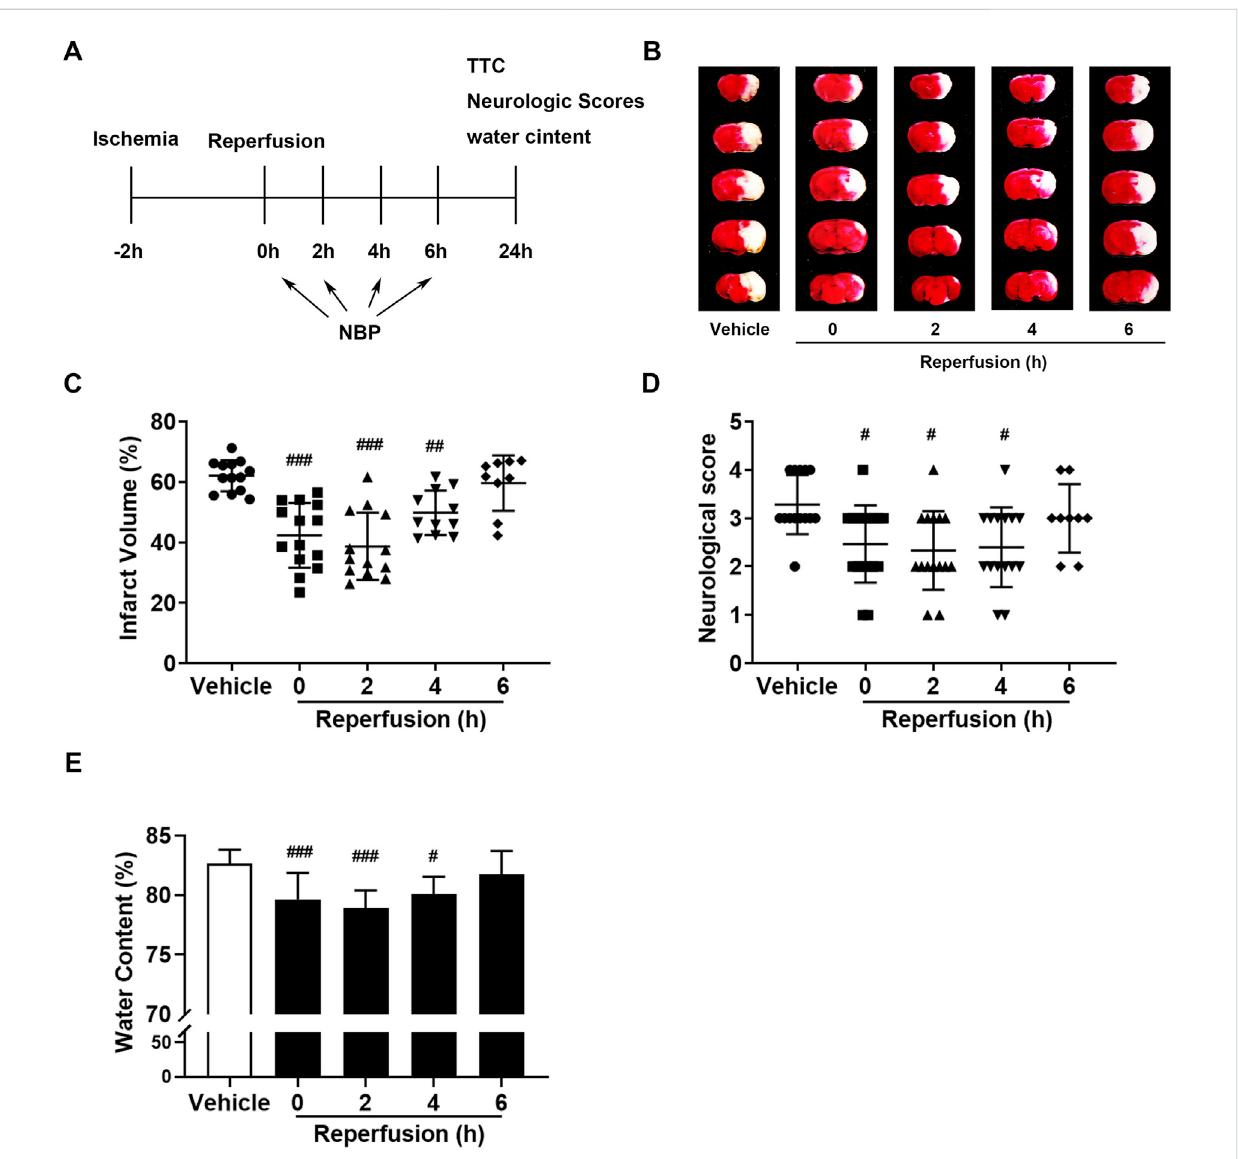
FIGURE 2 The therapeutic time window of NBP in the treatment of ischemia-reperfusion injury in mice. (A) In mice, MCAO was performed for 2 h, and NBP (30 mg/kg)wasmanagedbyintraperitonealinjectionat0,2,4and6 hafterreperfusion. (B,C) Representativeimagesofbraininfarction volumedetected with TTC staining. The neurological de fi cit score (D) and brain water content (E) 24 h after reperfusion. *p < 0.05, **p < 0.01 and ***p < 0.001 vs. vehicle, by One-way analysis of ANOVA followed by Tukey ’ s multiple comparisons test. Data were expressed as the mean ± SD. There were at least nine animals in each